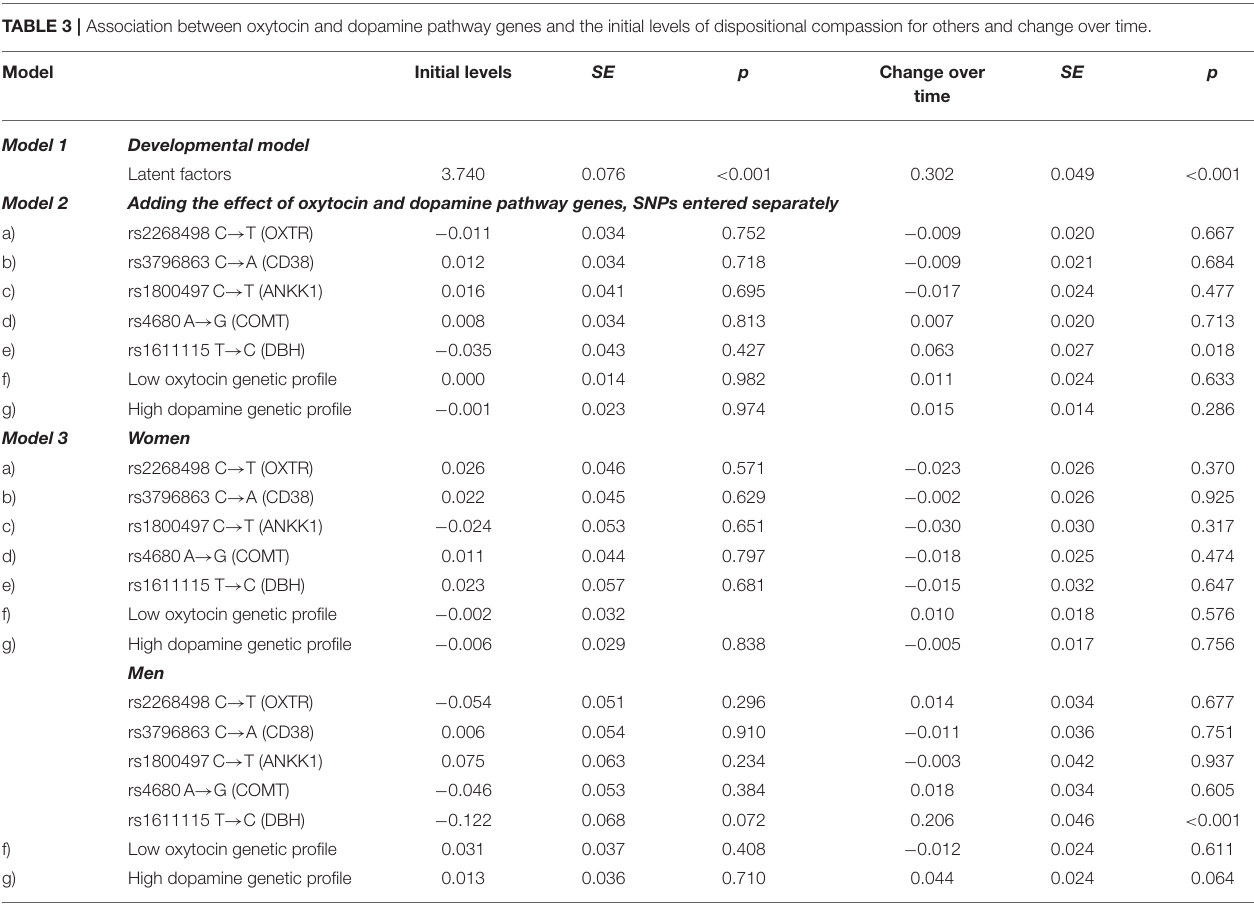
TABLE 3 | Association between oxytocin and dopamine pathway genes and the initial levels of dispositional compassion for others and change over time.